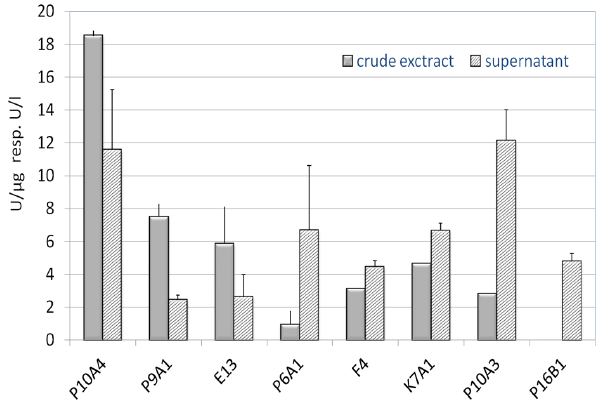
Fig. 5. Urease activity [UL − 1 ] in supernatant and specific activity [Uµg − 1 ] in crude